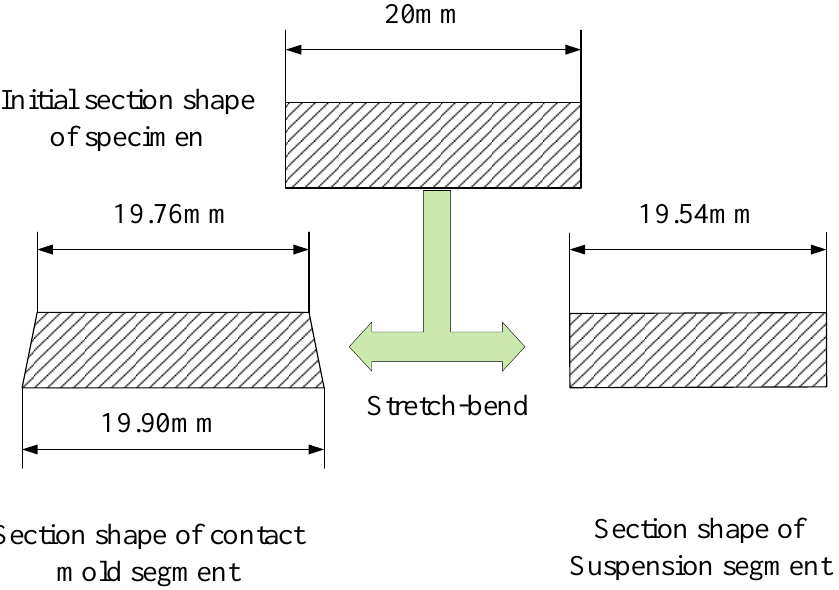
◦ contact mold stretch-bend